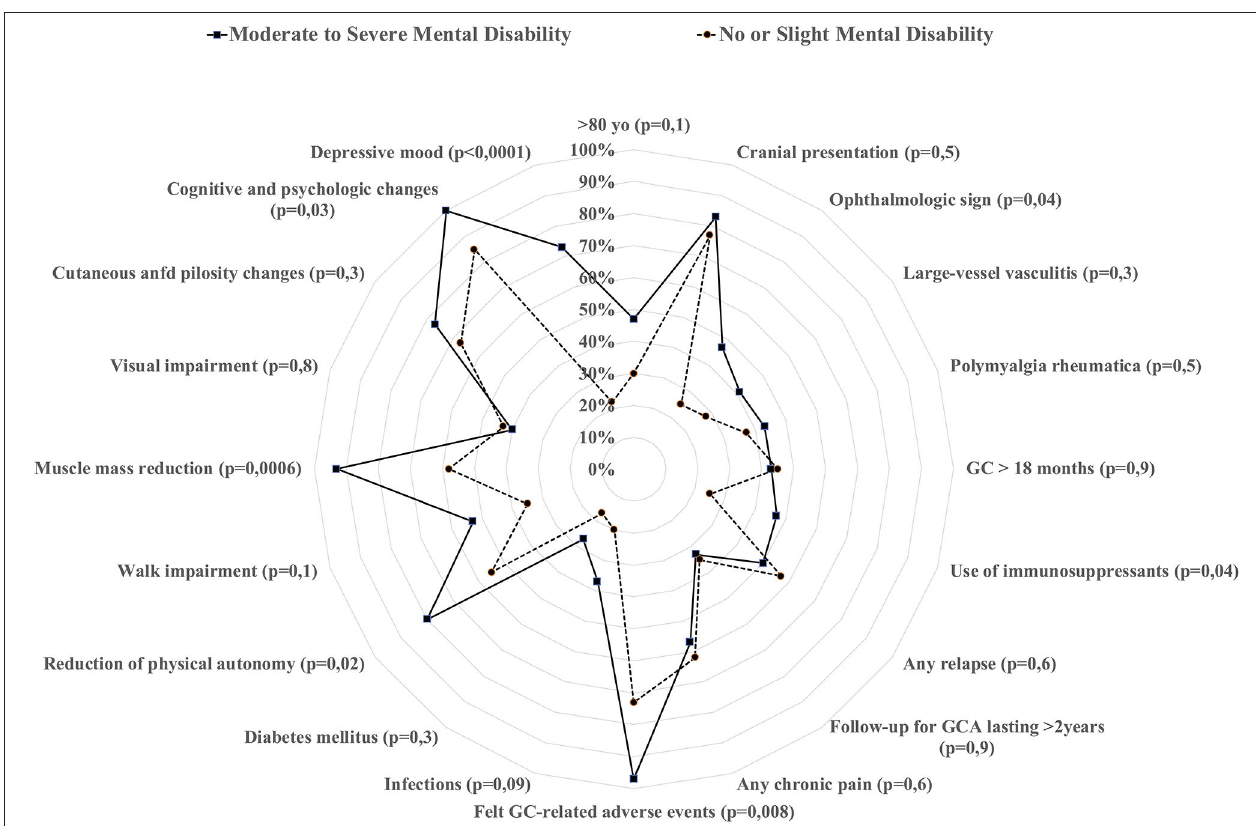
FIGURE 2 | Comparison of different characteristics at GCA baseline and during follow-up according to whether the patients stated they suffered from moderate-to-severe mental disability (calculated through the SF-12